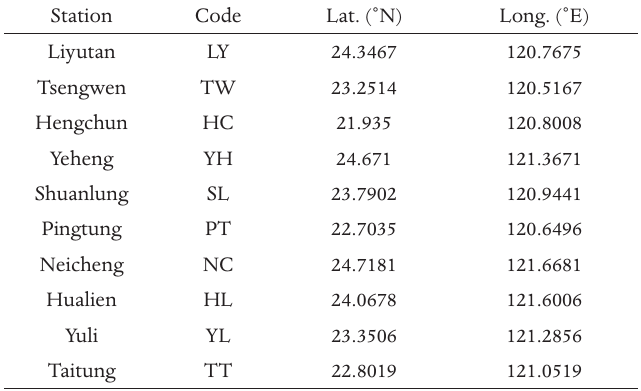
midpoint.Station Table 1. Geomagnetic stations in Figure 1. Map of Taiwan showing the locations of the 10 stations (red triangles) and 26 epicenters (blue circles). Green squares, the